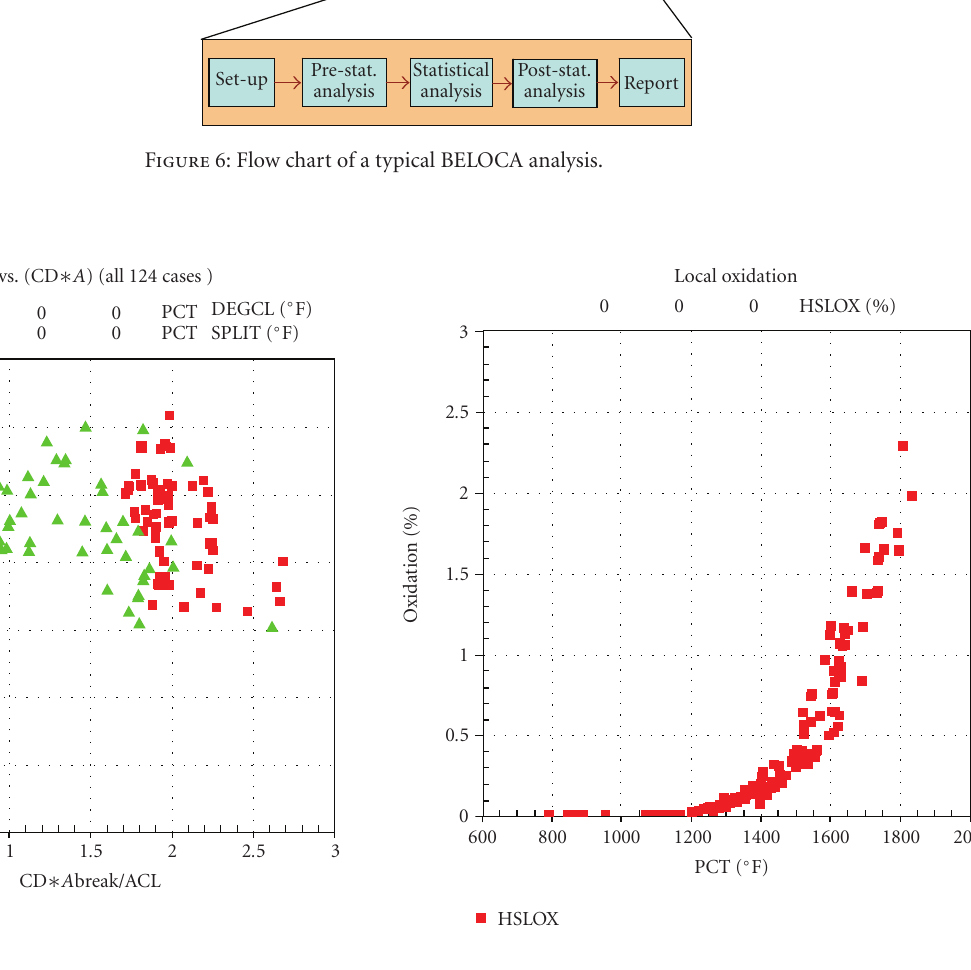
Figure 7: Peak clad temperature (PCT) from the ASTRUM 124 run set.